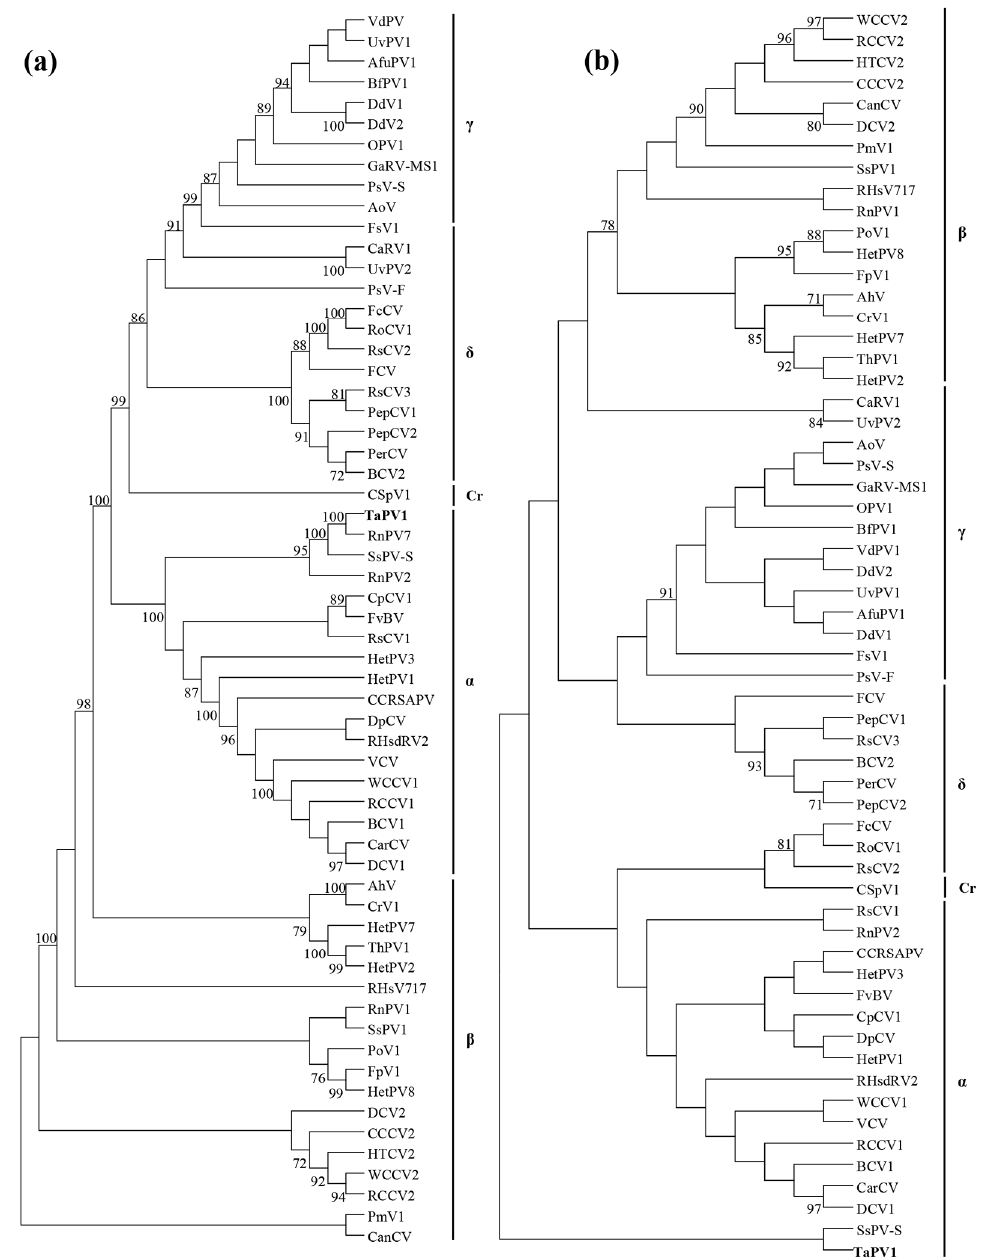
Figure 3. Phylogenetic analysis of TaPV1 and selected dsRNA viruses. ( a ) Maximum-likelihood (ML) tree using LG + F substitution model based on the RdRp amino acid sequences of Partitiviridae . α , Alphapartitivirus ; β , Betapartitivirus ; γ , Gammapartitivirus ; δ , Deltapartitivirus ; Cr, Cryspovirus . ( b ) ML tree for CP amino acid sequences of Partitiviridae . α , Alphapartitivirus ; β , Betapartitivirus ; γ , Gammapartitivirus ; δ , Deltapartitivirus ; Cr, Cryspovirus . The numbers at the nodes represent bootstrap values out of 1000 replicates; values are shown only if greater than 70%. See Table S1 for a detailed listing of